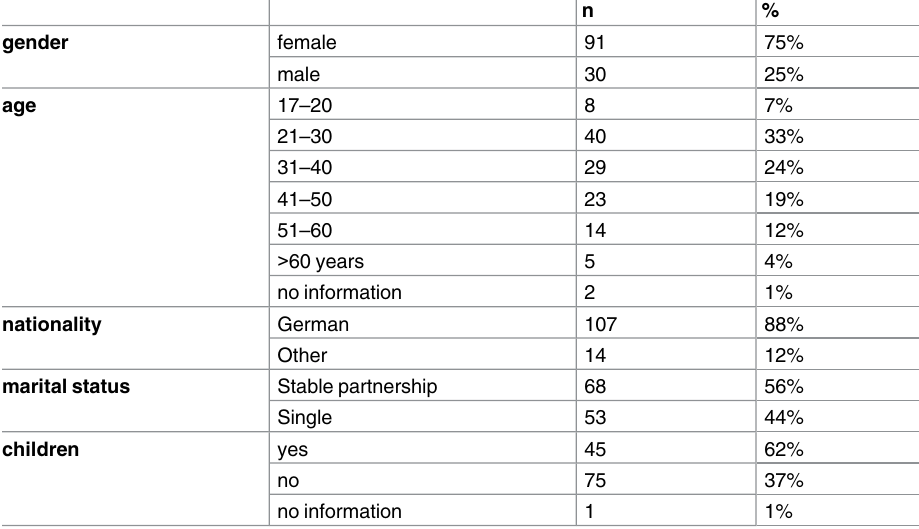
Table 1. Demographics of the survey